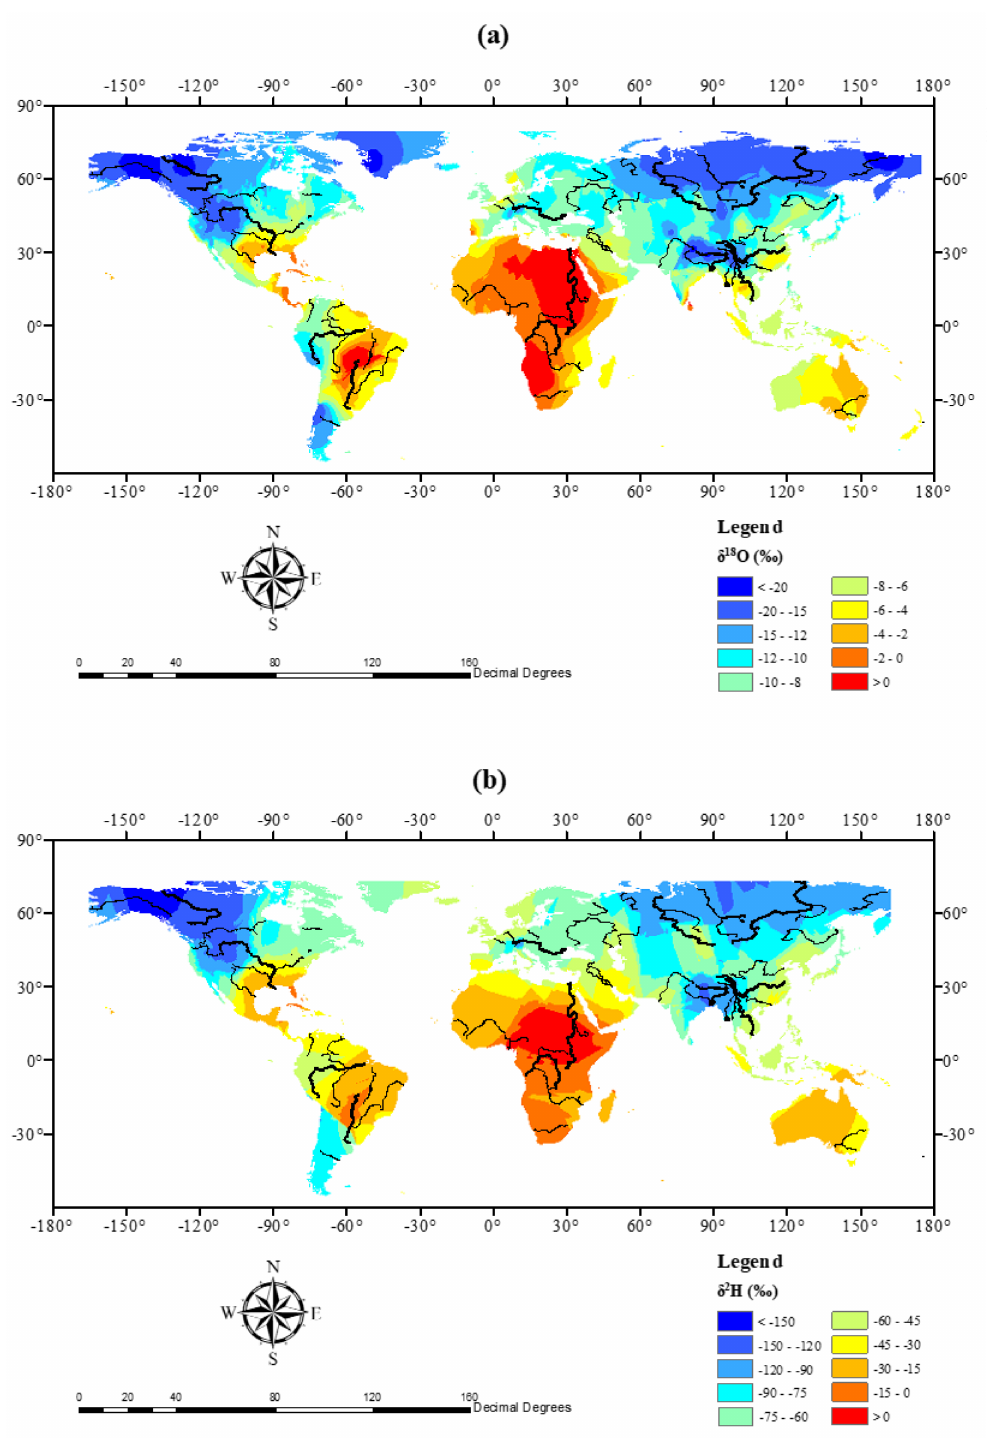
Figure 8. Global distribution of ( a ) δ 18 O and ( b ) δ 2 H in rivers. The values are overlaid on a background generated from Kriging interpolation model in ArcGIS 10.2. Black lines in the map are the major rivers